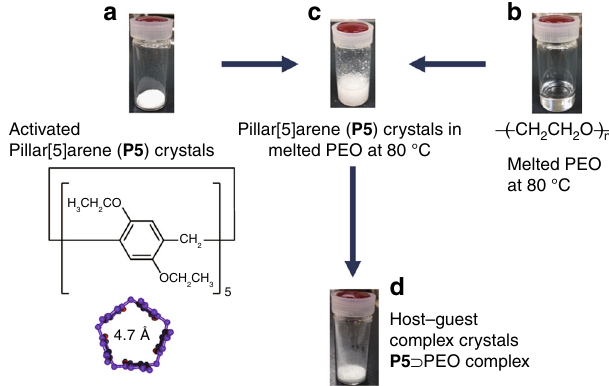
Fig. 1 Polymer encapsulation using activated pillar[5]arene crystals. a Activated crystals of pillar[5]arene ( P5 ). b Poly(ethylene oxide) (PEO) melted at 80 °C. c , d Host – guest complex crystals P5 ⊃ PEO produced by immersing activated crystals of P5 in melted PEO at 80 °C followed by washing the crystals with water to remove un-complexed